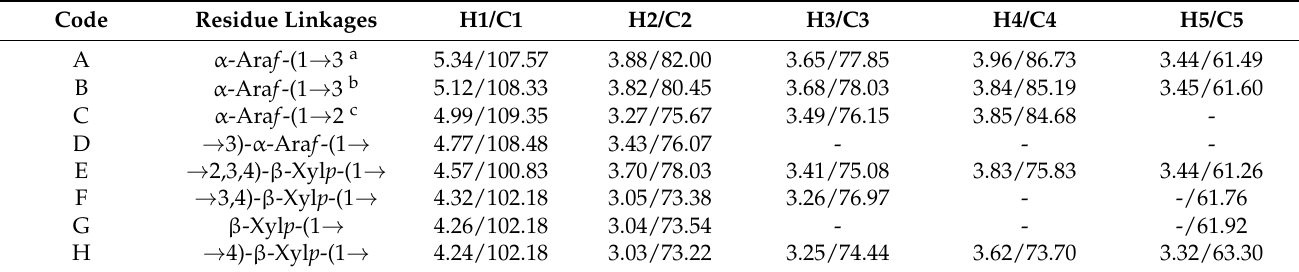
Figure 2. NMR spectra of HBAX-60: ( a ) 1 H NMR spectrum, ( b ) 13 C NMR spectrum, ( c ) HSQC NMR spectrum, and ( d ) COSY NMR spectrum. Table 3. Assignments of 1 H and 13 C NMR chemical shifts of